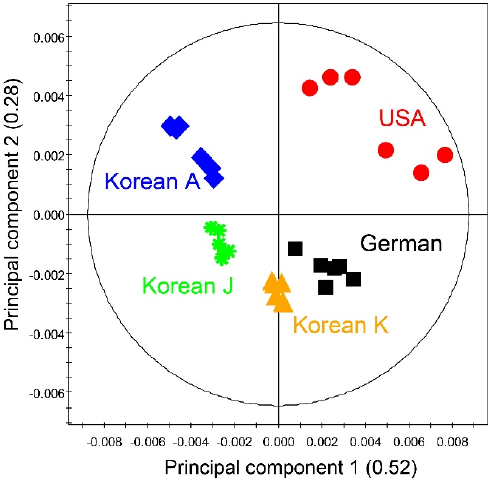
Figure 3. Principal component analysis (PCA) generated from 1 H NMR spectra of wheat malt extracts